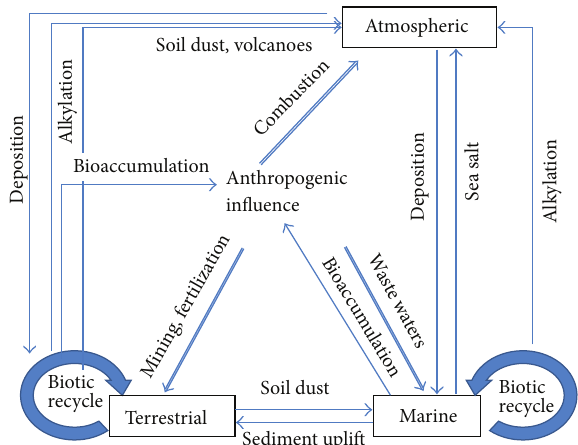
Figure 1: Global Se cycle considering the anthropogenic influence (extracted from